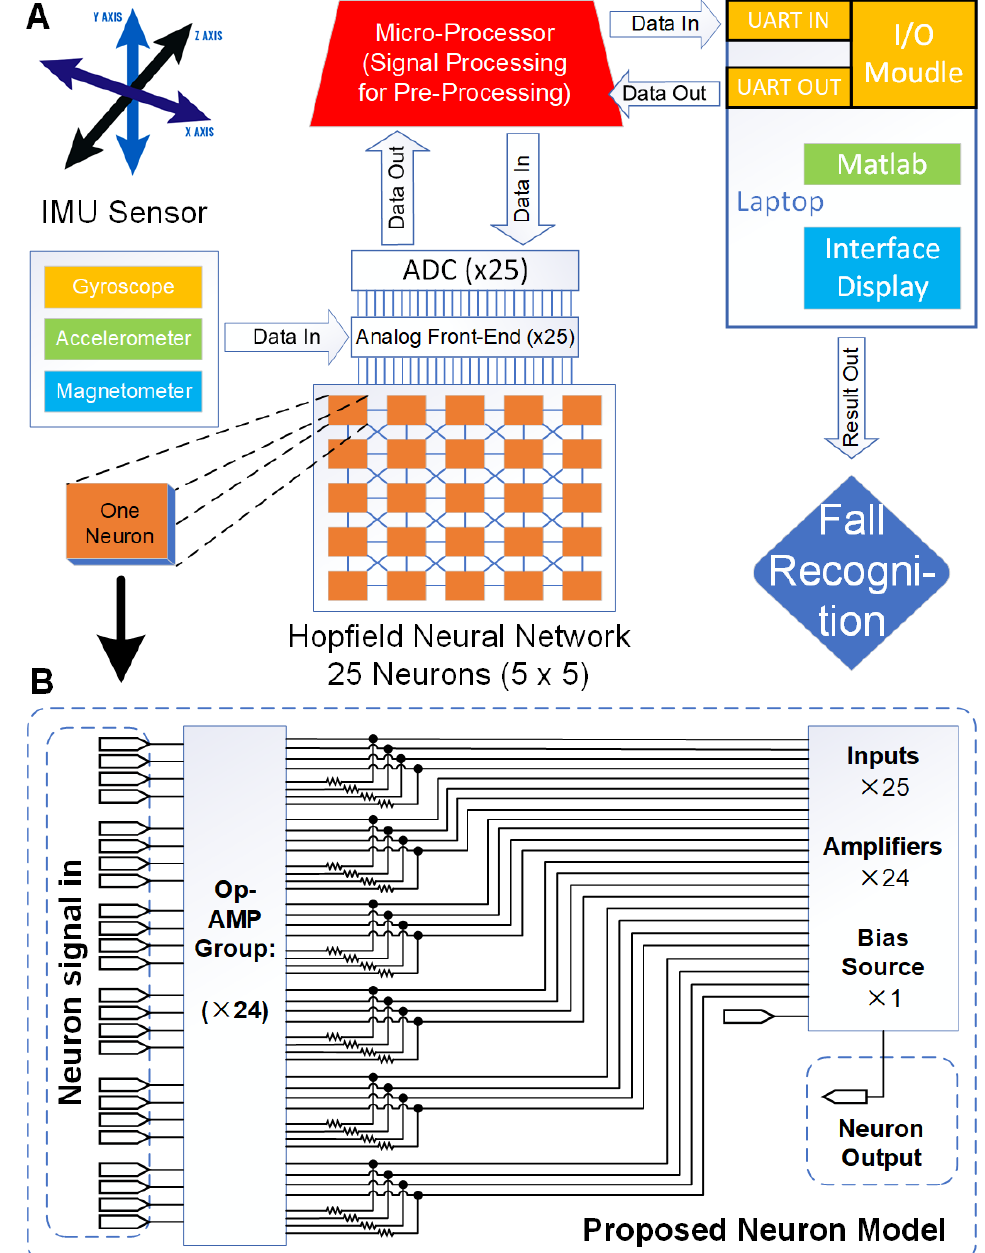
Figure 3. Hardware architecture for system